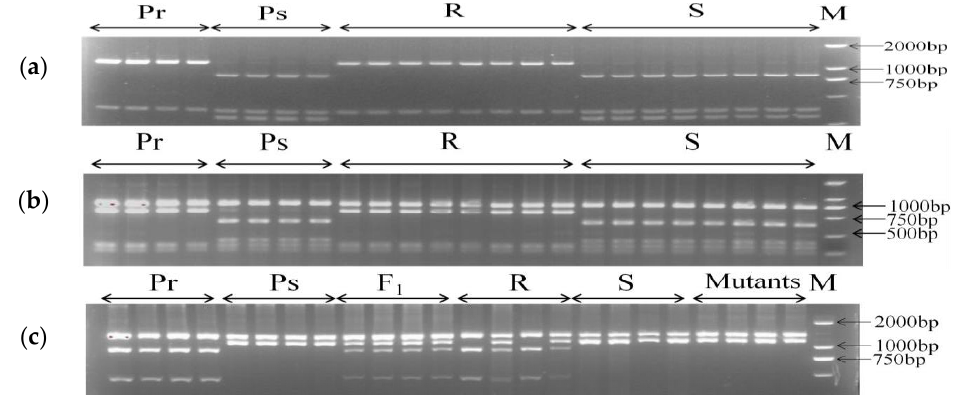
Figure 3. PCR amplification of polymorphic markers ( a , b , c ). Polymorphic test of CAPS markers H400, H732 and H736, respectively, on 1.5% agarose gel. Pr: Jimai 22, Ps: Avocet S, F 1 : F 1 plants, R: resistant F 2 plants, S: susceptible F 2 plants, M: Trans 2K DNA Marker. Table 2. Markers developed for mapping YrJ22.